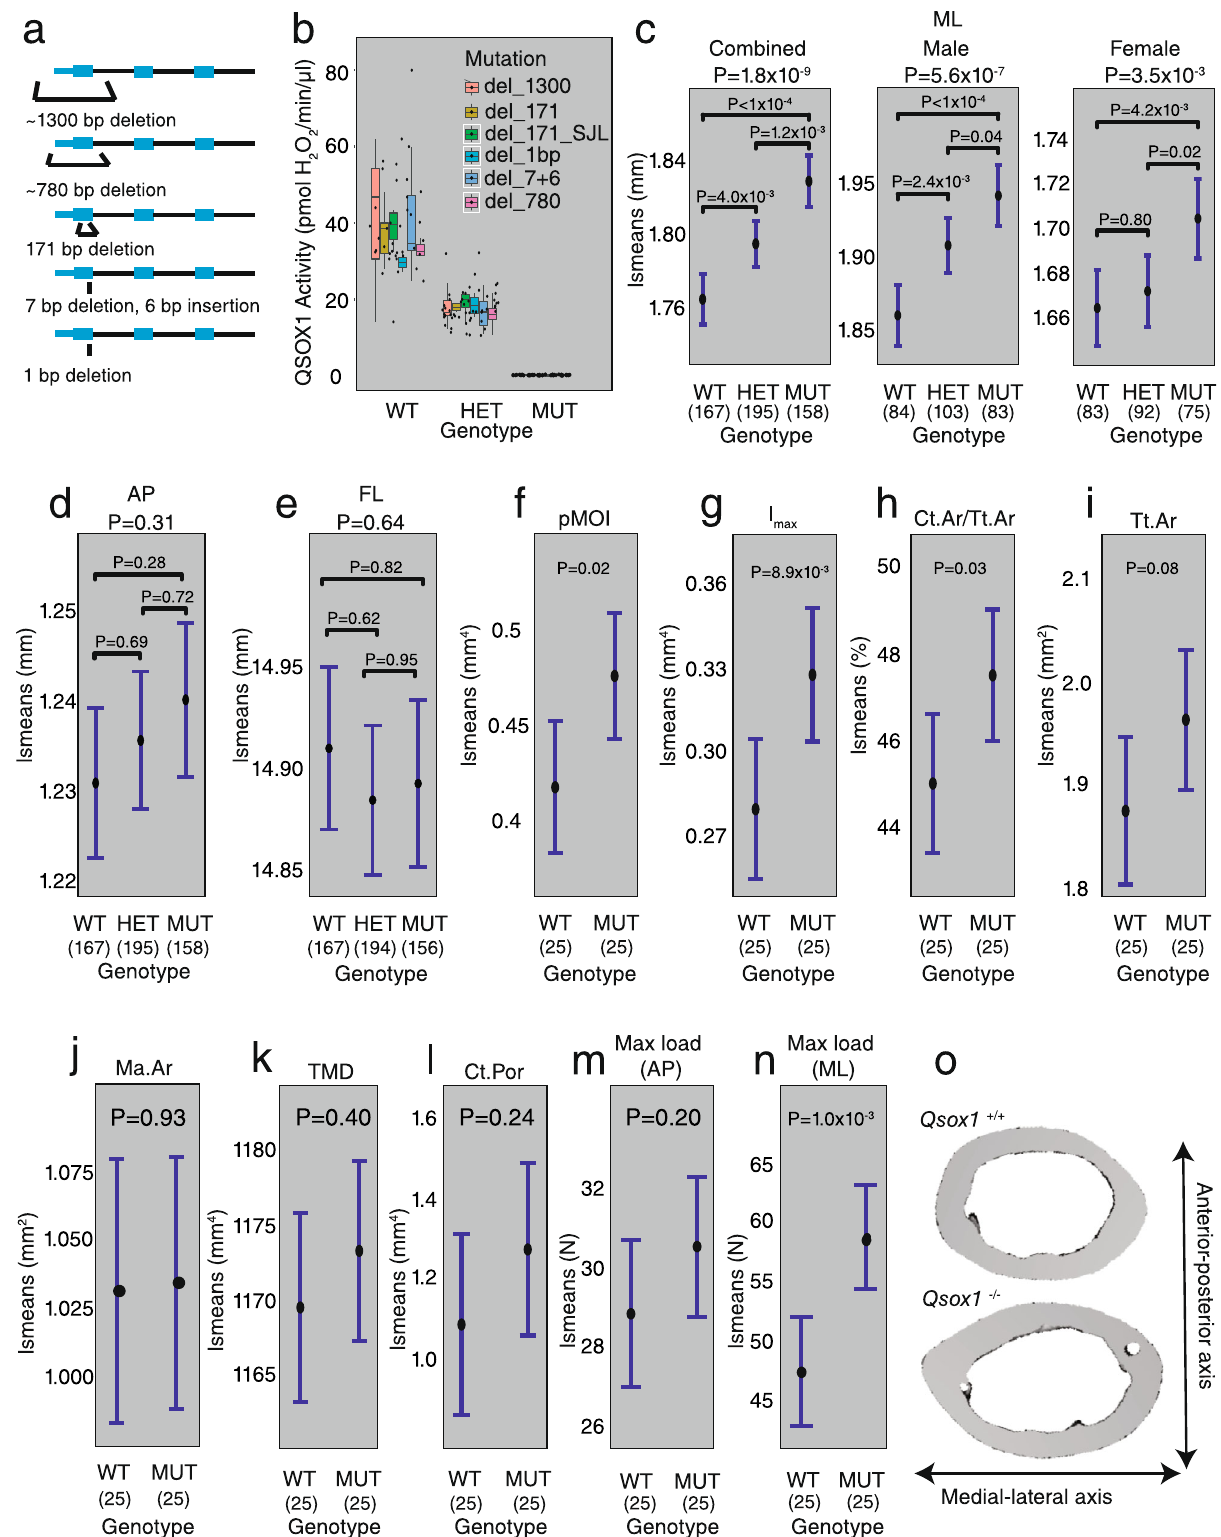
(Fig. 8g), and Ct.Ar/Tt.Ar ( P = 0.031) (Fig. 8h). Total area (Tt.Ar) (Fig. 8i) was increased, but the difference was only suggestive ( P = 0.08). Medullary area (Ma.Ar, P = 0.93) was not different (Fig. 8j). We observed no change in TMD ( P = 0.40) (Fig. 8k). We also observed no difference in cortical porosity (Ct.Por) ( P = 0.24) (Fig. 8l).